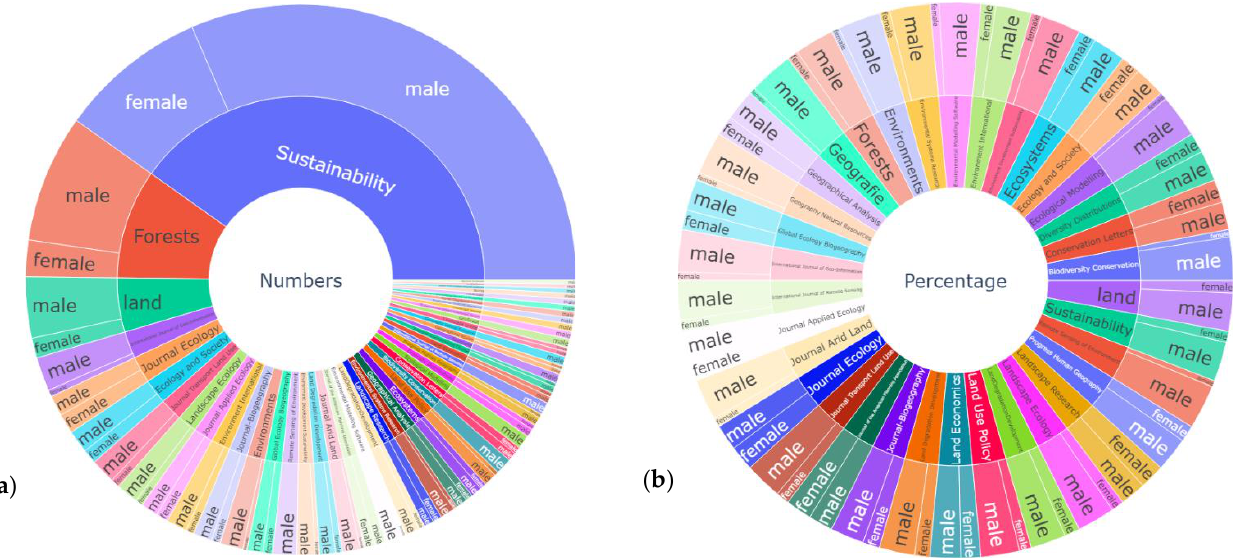
Figure 2. ( a ) The number and ( b ) The percentage of male and female editorial members in each LS journal selected.